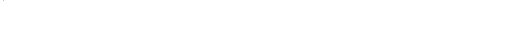
Figure 3. Detailed description of auto-encode (AE).